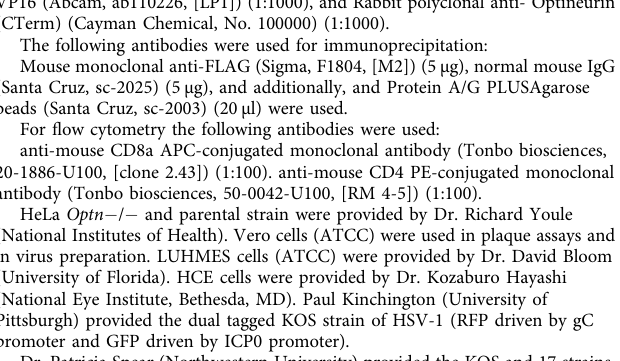
Fig. 5 OPTN is neuroprotective against herpes simplex virus encephalitis. Mice were infected using corneal scari fi cation using 5 × 10 5 PFU of HSV-1 McKrae strain. a – c Tissue plaque assay for trigeminal ganglion (left), brainstem (middle), and brain (right) ( n = 5 mice per group). Two-tailed Mann – Whitney U test was used where p < 0.05 indicates signi fi cance. d Weight changes of mice ( n = 5 mice per group) up to 7dpi. Two-way repeated- measures ANOVA F (3,42) = 9.908, p < 0.0001. e Kaplan – Meier curve for HSV-1 infected Optn + / + ( n = 8) and − / − ( n = 8) mice. Logrank test was used to compare curves with p < 0.05 being signi fi cant. f , g (left) Quantitation of TUNEL stained cells in brainstems of Optn + / + and − / − mice 8dpi ( n = 4 mice per group). (right) Representative images of H&E staining and TUNEL staining (dark brown) for brainstems. Arrows highlight TUNEL positive cells.